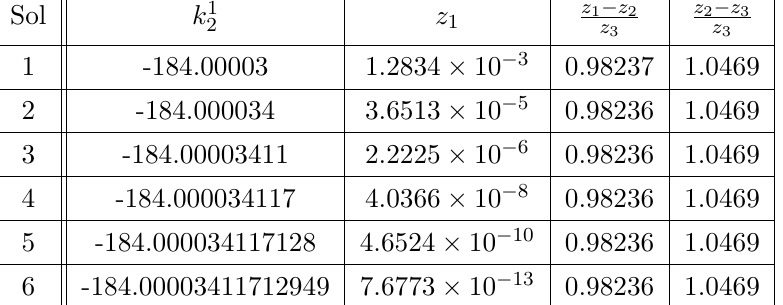
Table 2 . Scaling process of the solution with one supertube and three Gibbons-Hawking centers with aspect ratios of order